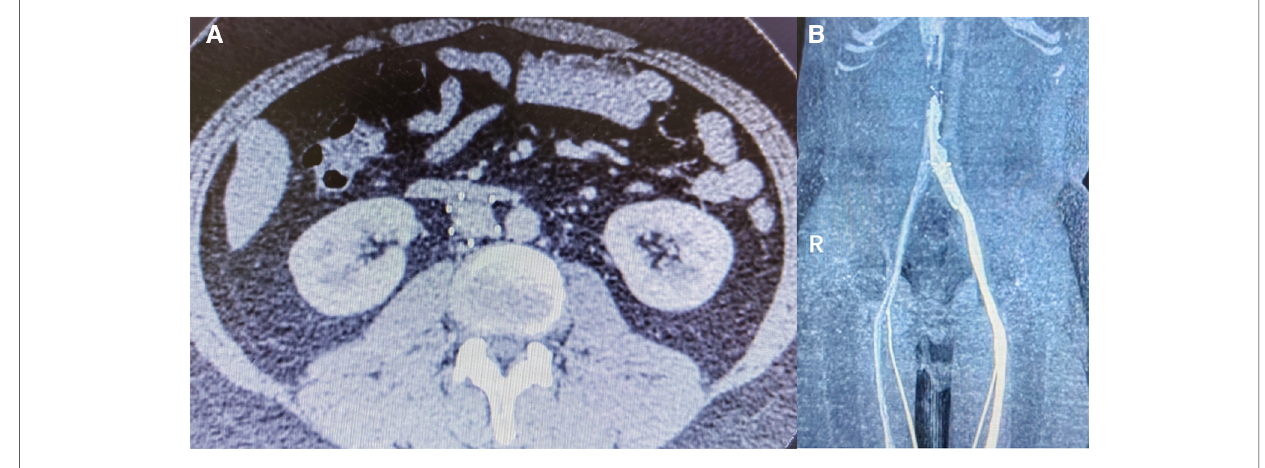
FIGURE 4 ( A ) Retention of non-conical fi lter for 6 years, fractured. ( B ) IVC occlusion in the follow-up at 3 months after